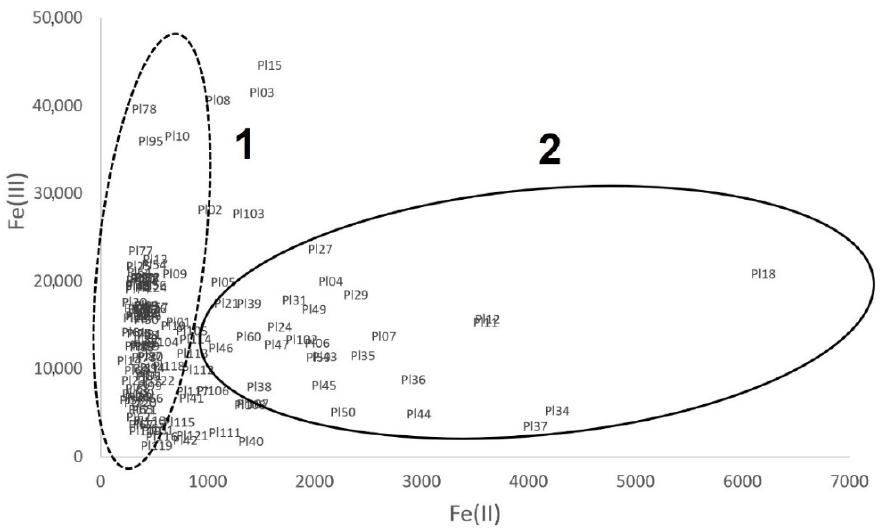
Figure 5. The iron speciation in pottery samples: 1—the group of samples “similar to” pottery from sites B and G; 2—the group of samples “similar to” pottery from sites M and P. The factor Fe(III)/Fe(II) for samples from site Pl was shaped in a very broad range: from 1 to 485 (Figure 6).